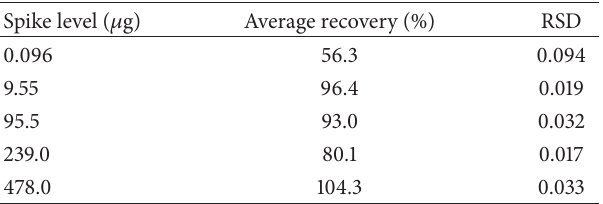
Table 4: Diacetyl recovery after extraction of spiked sorbent with o -PDA solution.